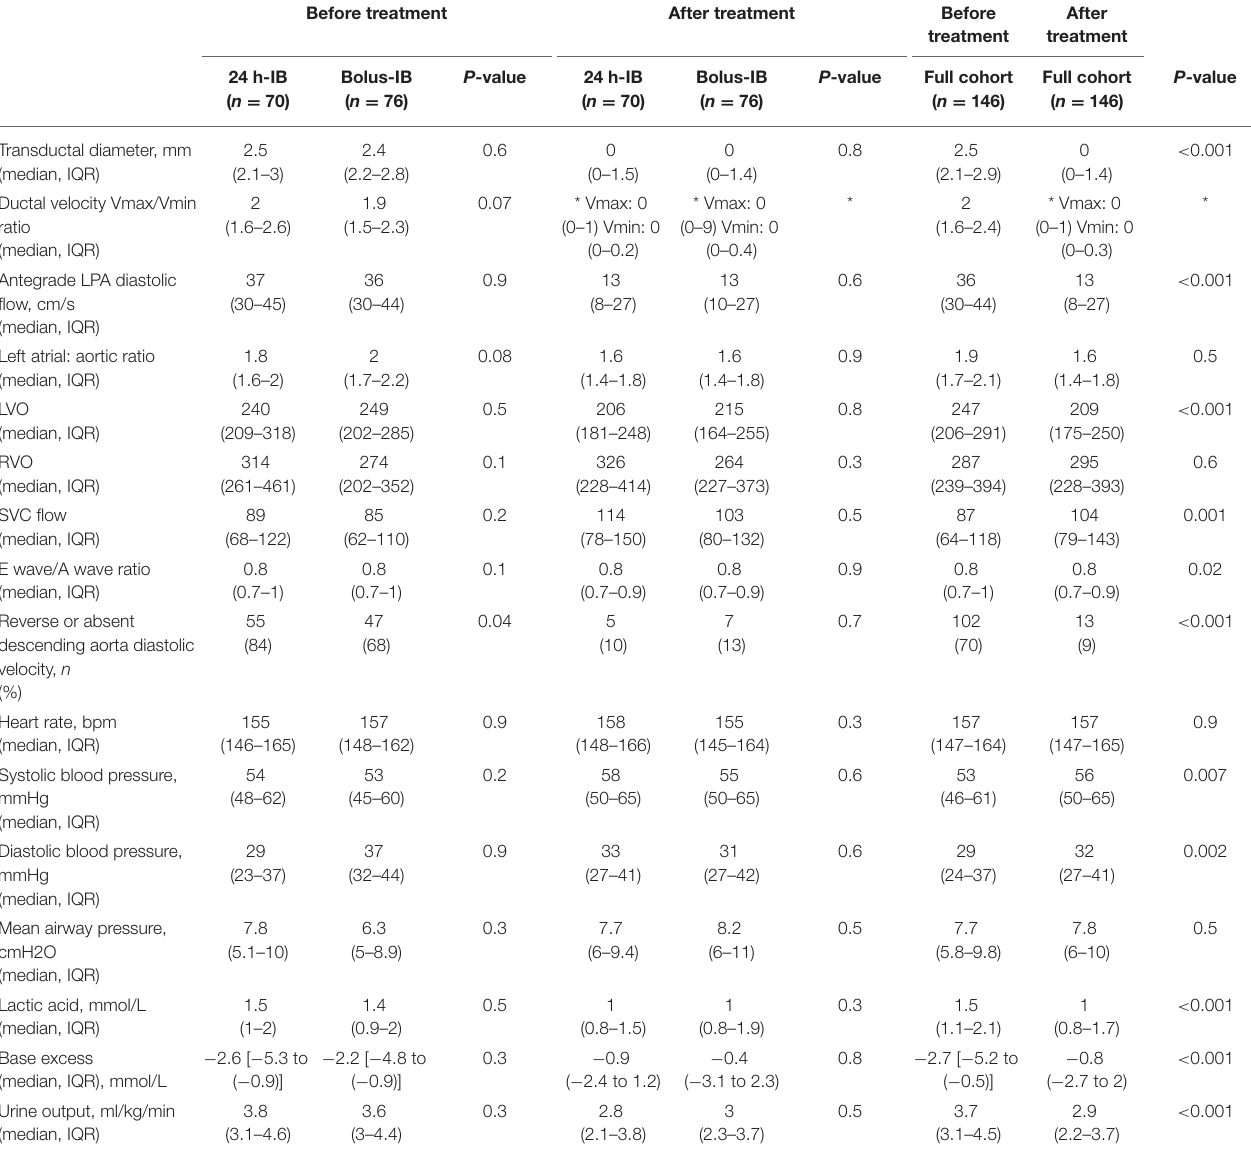
TABLE 2 | Evolution of cardiorespiratory status and echocardiographic variables during the intervention. Before treatment After treatment Before